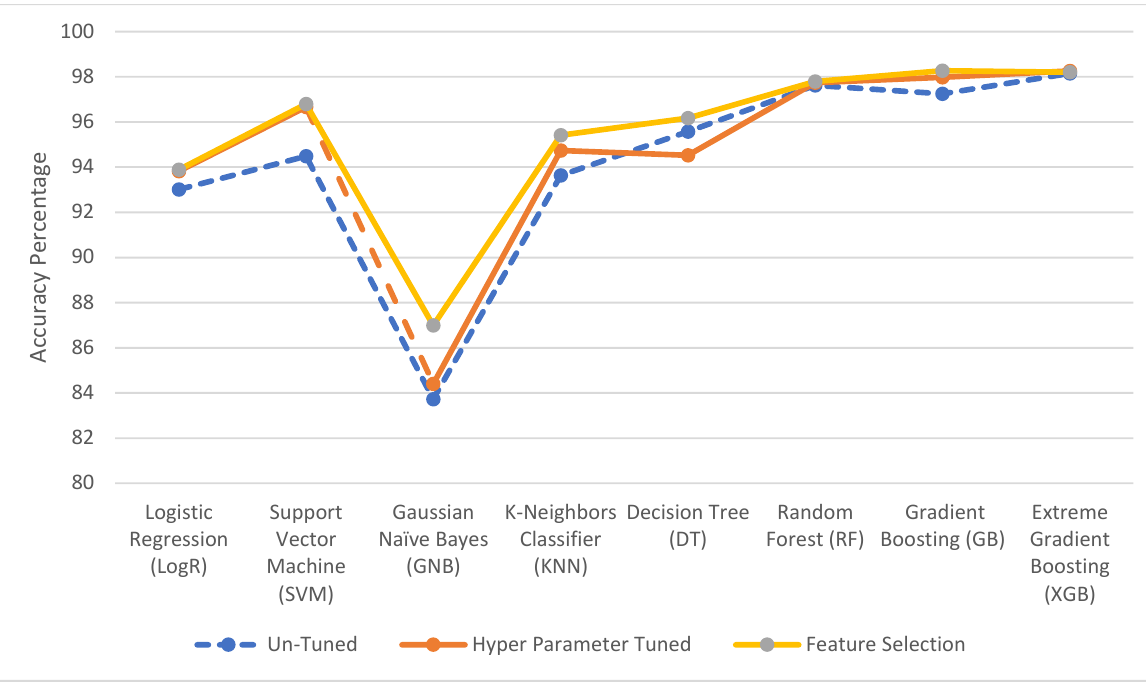
Table 18. Performance comparison of existing and fine-tuned method for Dataset-1 and Dataset-2.